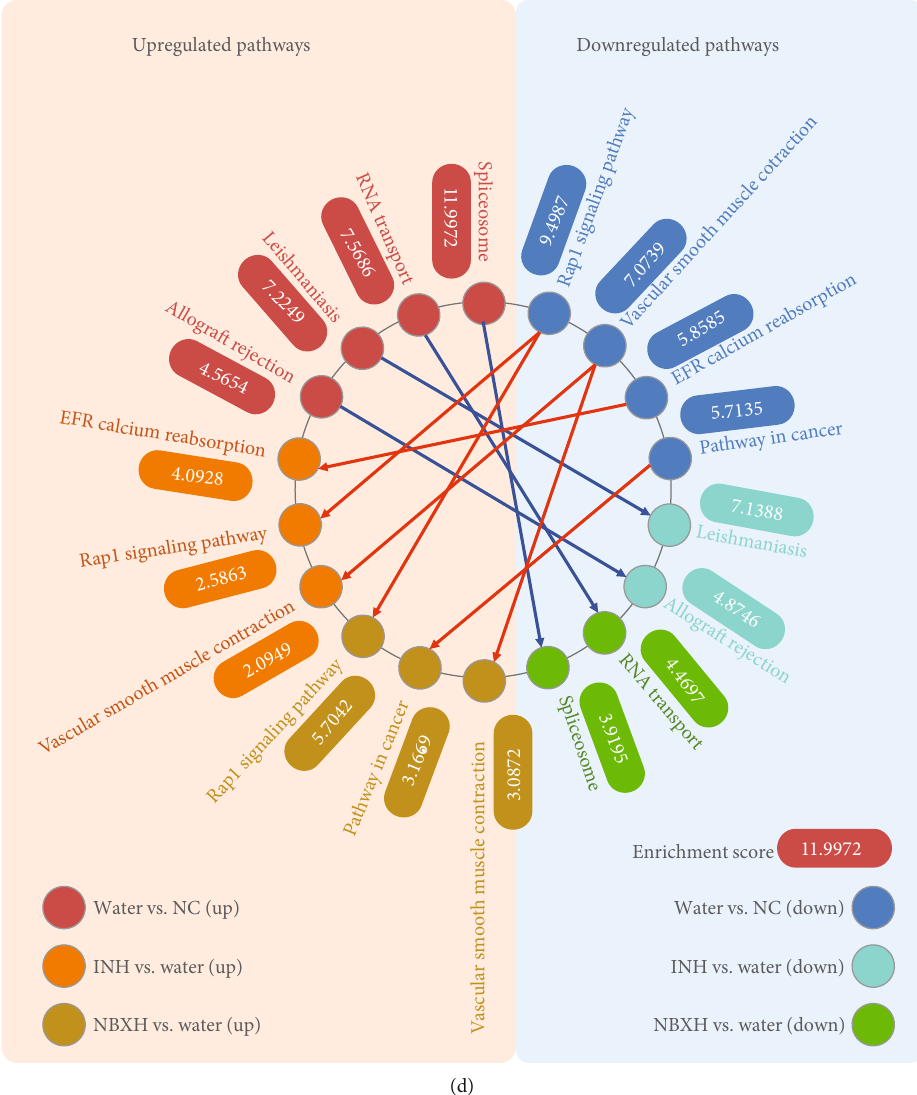
Figure 7: Pathway analysis and relationship networks of DE genes between before and after M. tuberculosis infection and INH or NBXH-H treatment. Pathway bar plot explanation and pathway map explanation. The signi fi cantly up- or downregulated pathways were ranked by enrichment score (-log10 ( P value)) value. The top 10 up- or downregulated pathways between the Water-treated group and the NC group (a), between the INH-treated group and the Water-treated group (b), or between the NBXH-H-treated group and the Water-treated group (c) are shown as bar plots. Additionally, the relationship networks of DE genes associated with the top 10 up- or downregulated pathways are made by PowerPoint software (d). The pathways located in the orange region on the left were signi fi cantly upregulated, while the pathways located in the light blue zone on the right were signi fi cantly downregulated. The interactions between pathways that were signi fi cantly upregulated in the Water vs. NC groups but downregulated in the INH vs. Water or the NBXH-H vs. Water groups are shown in the blue lines, the interactions between pathways that were signi fi cantly downregulated in the Water vs. NC groups but upregulated in the INH vs. Water or the NBXH-H vs. Water groups are shown in the red